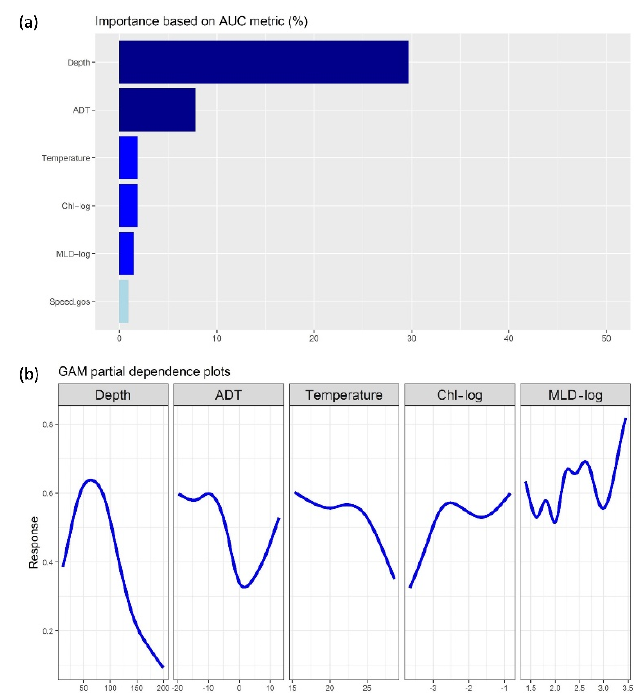
Figure 2. GAM results: ( a ), barplots of variable importance scores based on AUC-metric. The dark blue, blue and light blue colored bars indicate variables with high significance ( p -value < 0.01), moderate significance (0.01 ≤ p -value < 0.05) and no significance ( p -value ≥ 0.05), respectively. ( b ), partial plots of significant ( p < 0.05) parameters are shown.